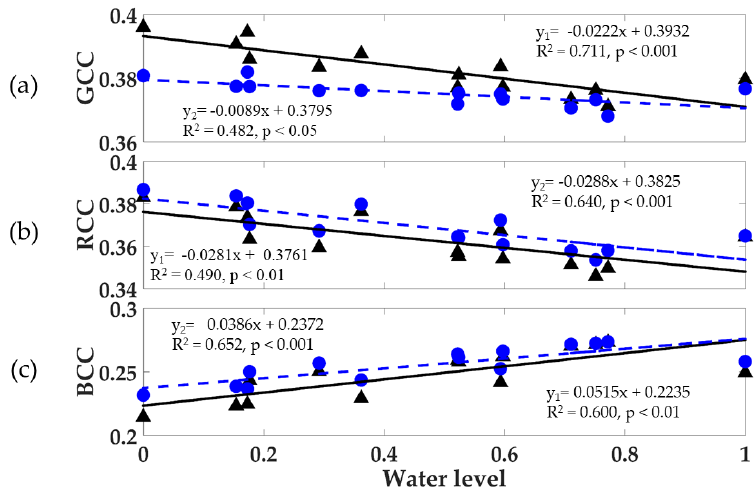
Figure 9. The relationship between ( a ) GCC, ( b ) RCC, and ( c ) BCC seasonal values with the seasonal normalized water level for the mangrove forest (black triangle, y 1 relationship) and mangrove-water canopy (blue dot, y 2 relationship). The data were calculated monthly from July 2015 to August 2016. The mangrove forest relationship with the water level would be an indirect, non-causal one, a consequence of peak mangrove greenness occurring in the dry season when water levels were at their lowest, while wet season GCC values were minimal when water levels were at their highest. Furthermore, daily water tidal levels greatly exceed water level differences between dry and wet seasons. The water level influences on mangrove forest phenocam indices can be evaluated by comparing the water level relationships of the combined mangrove–water canopy with the mangrove forest only. In the dry season, the presence of the water background exerted its greatest negative influence on GCC values, a result of the greater presence of mud, soil, and sediment exposure (Figure 9a). Thus, the mangrove forest phenology contrast between dry and wet seasons was considerably dampened by the presence of the water background GCC signal in the combined ROI. The mangrove forest RCC values were also negatively correlated with the water level (R 2 = 0.490, p < 0.01) and this relationship became stronger (R 2 = 0.640, p < 0.001) with the presence of water in the mangrove–water canopy (Figure 9b). The RCC values of the mangrove–water canopy were higher than those from the mangrove forest. The lower water levels in the dry season contributed to the positive RCC signals due to the presence of muddy waters and exposed soil. On the other hand, the mangrove forest BCC values showed a positive relationship with the water level (R 2 = 0.600, p < 0.01) and the inclusion of the water background with the mangrove forest increased the BCC values and strengthened the BCC relationships (R 2 = 0.652, p < 0.001) with the water level. 4. Discussion The two in situ phenocams were found to provide valuable information on the phenology of mangrove forests and offer strong monitoring capabilities of the mangrove–water background canopy at very fine temporal resolutions. As shown in this study, phenocams can be readily deployed in many different locations with minimal resources and their imagery can be spatially segmented into distinct regions of interest